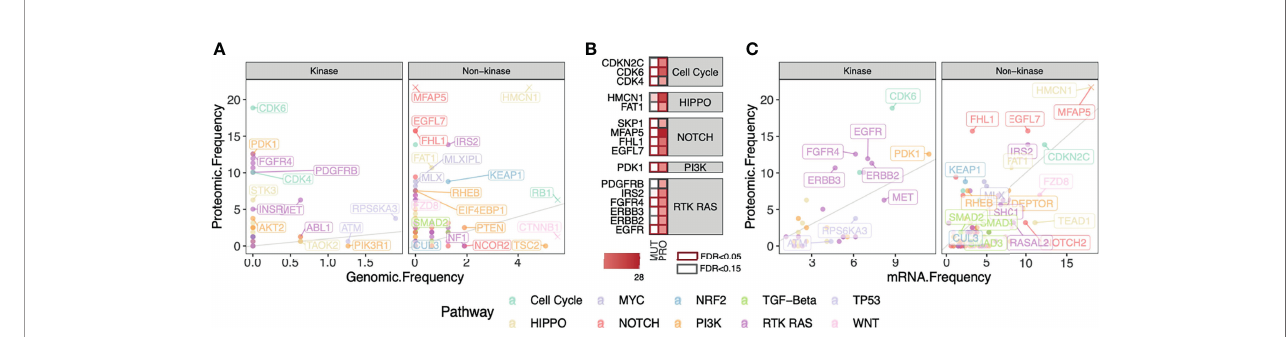
FIGURE 4 | Comparison between fractions of cases carrying DNA, RNA, and Protein-level alterations in kinase and non-kinase targets in HCC. (A) Fractions of HCC cases carrying truncating or recurrent missense somatic mutations in the oncogenic signaling pathways compared to those showing protein overexpression in the HCC-Gao cohort. Top markers with high genomic and/or proteomic alterations are labeled. For better visualization of other data points, the outlying values of HMCN1 (original values: DNA = 4.4%, PRO = 22.6%), MFAP5 (DNA = 0%, PRO = 27.7%), RB1 (DNA = 5.7%, PRO = 6.3%), and CTNNB1 (original values: DNA = 18.4%, PRO = 1.3%), are truncated. (B) Proteins in panel A that show signi fi cant enrichment of protein overexpression (FDR < 0.15) tend to have low fractions of somatic mutations. (C) Fractions of HCC cases showing mRNA and protein overexpression frequencies of the genes in oncogenic signaling pathways in HCC-Gao cohort. The outlying values of HMCN1 (original values: RNA = 20%, PRO = 22.6%) and MFAP5 (RNA = 40%, PRO = 27.7%) are